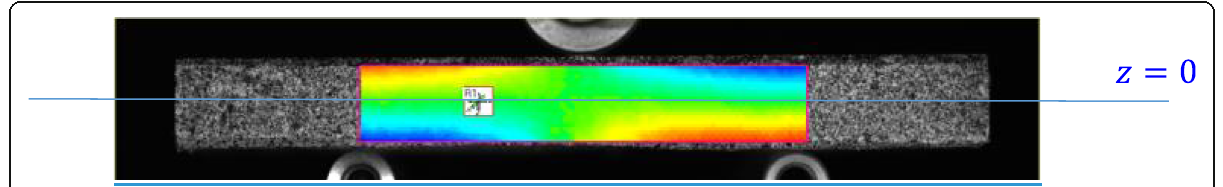
Fig. 9 Virtual gage positioned on DIC longitudinal displacement field to calculate the mean